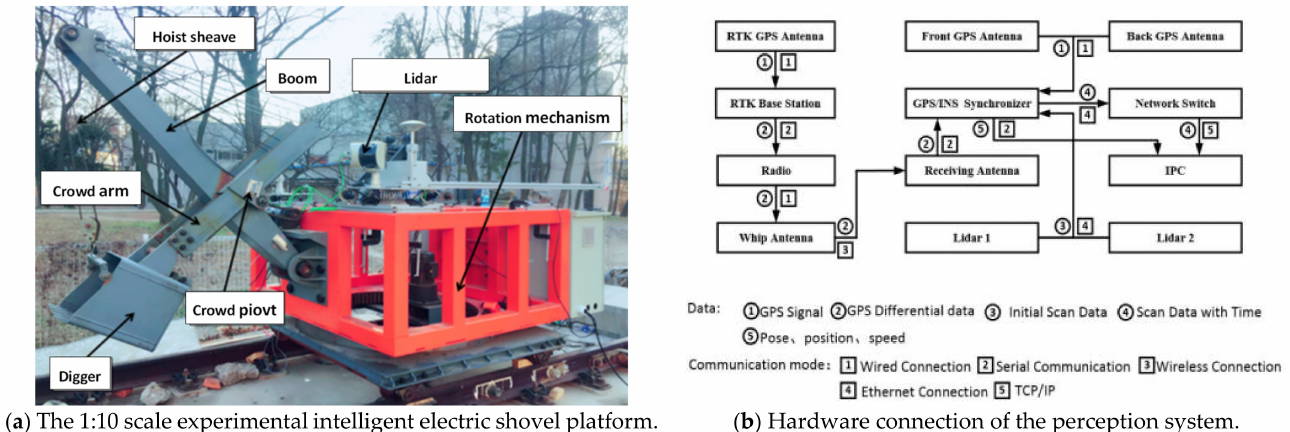
Figure 1. The electric shovel platform and hardware